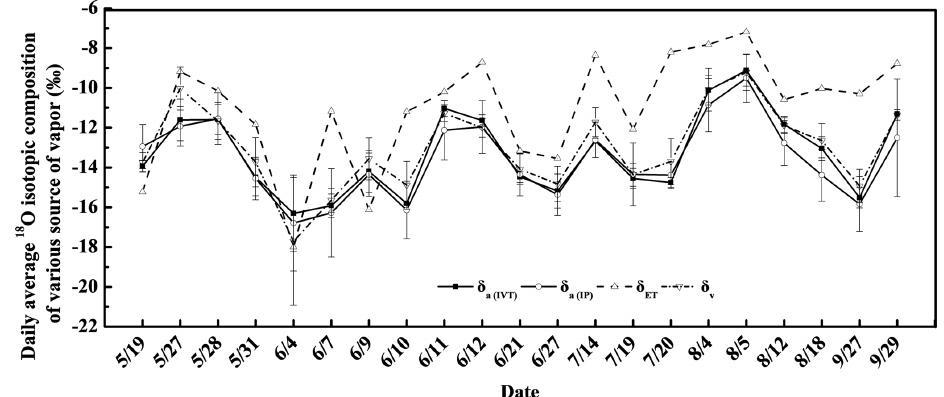
Figure 2. The daily average values of the isotope composition of evapotranspiration vapor ( δ ET ), the isotope composition of atmospheric vapor ( δ v ), the estimated isotope composition of ambient vapor using the intersection point method ( δ a(IP) ) and the intermediate value theorem method ( δ a(IVT) ) in the 21d time frame (see the method in Sect. 2.3). Please note that the date format in this figure is month/day.